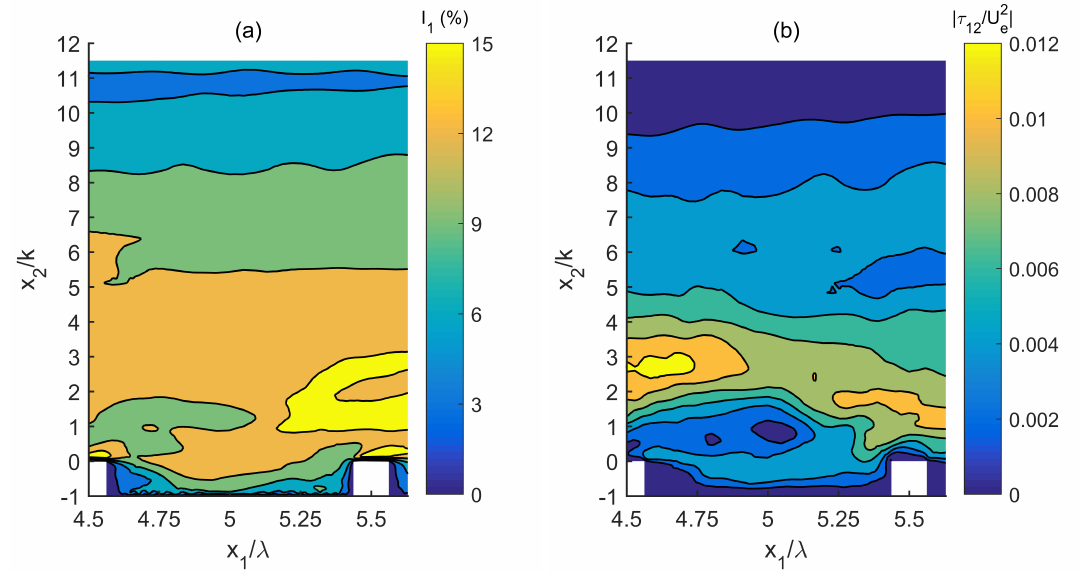
Figure 11. Vertical planes (at x 3 = 0.0375 m) showing predicted distributions of: ( a ) relative turbulence intensity component I 1 in the streamwise direction; ( b ) specific Reynold shear stress − u (cid:48) by the freestream velocity squared U 2 e . The distributions are from LES outputs for Run